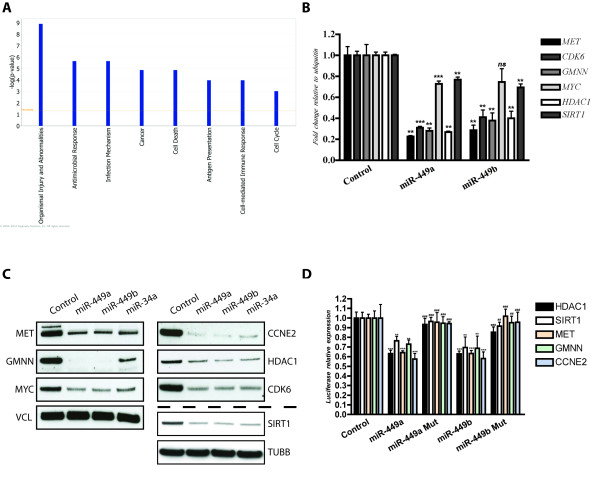
miR-449 targets cell cycle controller genes. A - Ingenuity Pathway Analysis (IPA) of deregulated genes upon miR-449 re-introduction into SNU638 cells showing enrichment for the gene categories cancer, cell death and cell cycle pathways among others. B - qPCR validation of Affymetrix arrays showing down-regulation of MET, CDK6, GMNN, MYC and HDAC1 upon miR-449 re-introduction compared to scrambled RNA controls. C - Western blot validation of down-regulated genes upon miR-449 re-introduction into SNU638 cells compared to scrambled RNA controls. Vinculin (VCL) and tubulin beta (TUBB) were used as loading controls D - verification of direct and functional target binding using luciferase constructs holding wild type 3'UTRs and mutated 3'UTRs (two mutations in miR-449 binding site), * indicates statistical significance in luciferase expression between wild type 3'UTRs transfected with miR449a/b compared to RNA scrambled control, # indicates statistical difference in luciferase expression between wild type 3'UTRs compared to mutant 3'UTRs transfected with miR-449a and miR-449b. "ns" not significant p value > 0.05, "*" or "#" significant 0.01 < p value < 0.05, "**" or "##" very significant 0.01 < p value < 0.001, "***" or "###" extremely significant p value < 0.001